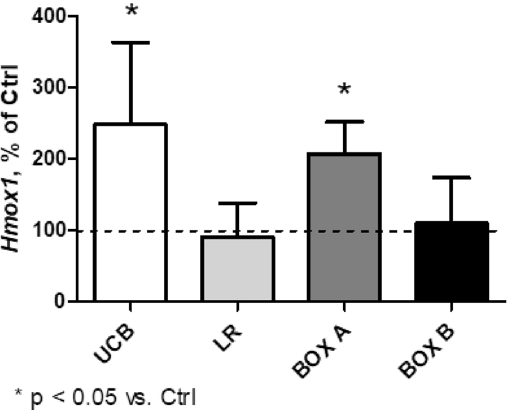
Figure 3. Expression of Hmox1 mRNA in organotypic rat hippocampal slices after 4 h exposure to UCB, LR, BOX A, or BOX B. Expression of Hmox1 in control organotypic rat hippocampal slices was set to 100%. Concentrations of tested compounds = 25 μ